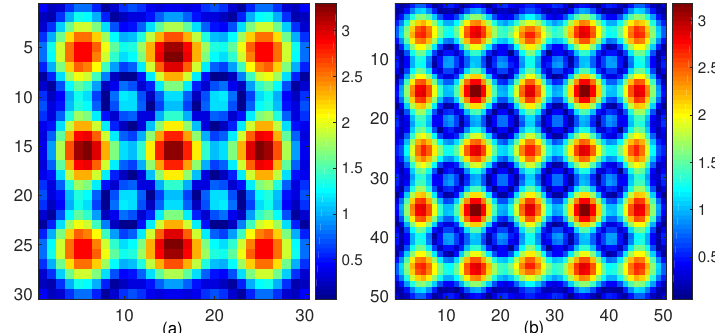
I x )( r ) | in the plane x = 0 when I x = 1 for a DoI with size ( a ) 3 λ × 3 λ × 3 λ Figure 2. The values of | ( G 3D D; xx and ( b ) 5 λ × 5 λ × 5 λ